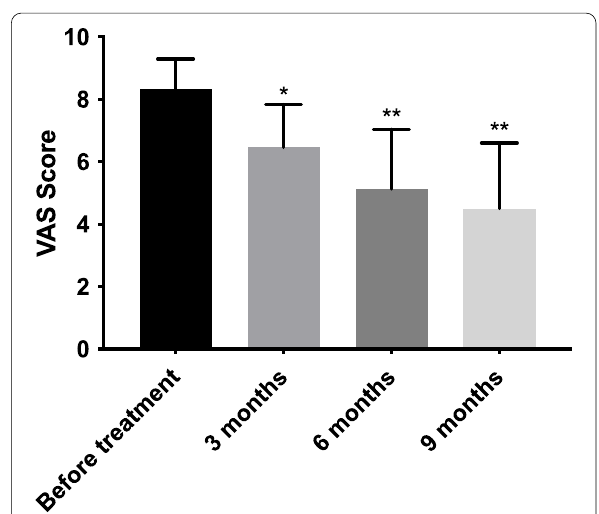
Fig. 1 Mean functional Visual Analogue Scale (VAS) scores ( n 24) before and after Lipocell treatment. Error bars show = standard deviation. * p vs. before treatment < 0.05; ** p vs. before treatment < 0.01